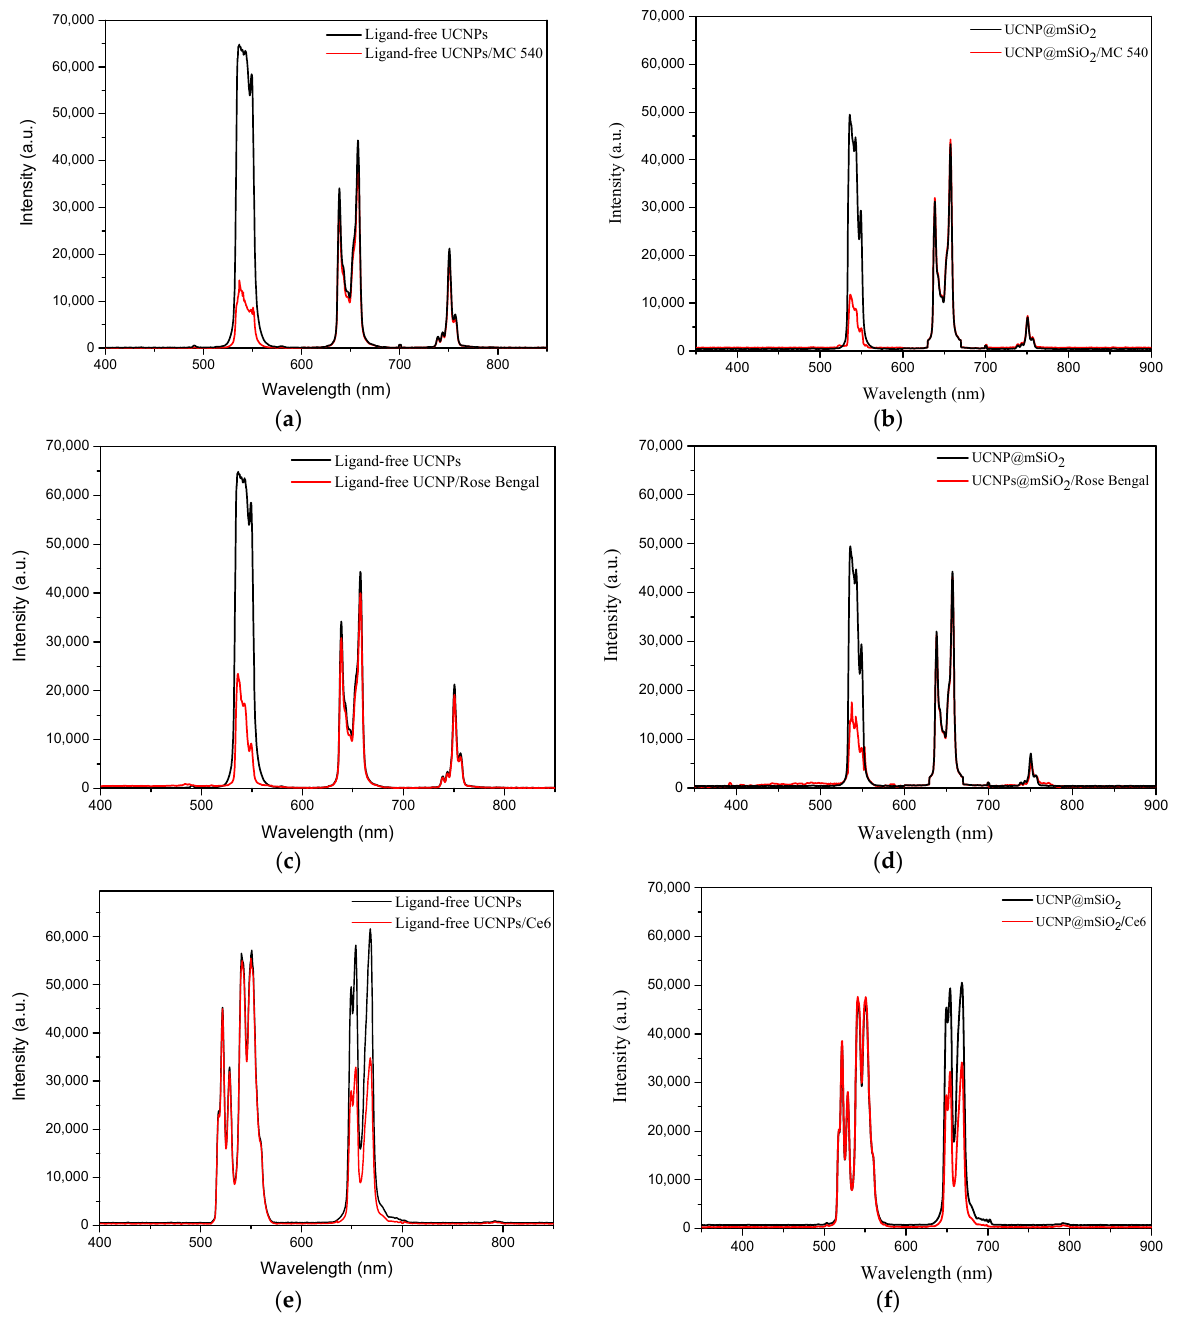
Figure 6. PL spectra of nanoparticles under 980 nm NIR excitation before and after adsorption of PS molecules. ( a ) Ligand-free, and; ( b ) mSiO 2 -coated LiYF 4 : Yb 3+0.25 /Ho 3+0.01 @ LiYF 4 :Yb 3+0.2 with MC 540; ( c ) ligand-free, and; ( d ) mSiO 2 -coated LiYF 4 : Yb 3+0.25 /Ho 3+0.01 @ LiYF 4 :Yb 3+0.2 with rose bengal; ( e ) ligand-free, and; ( f ) mSiO 2 -coated LiYF 4 : Yb 3+0.25 /Er 3+0.01 @ LiYF 4 :Yb 3+0.2 with Ce6.